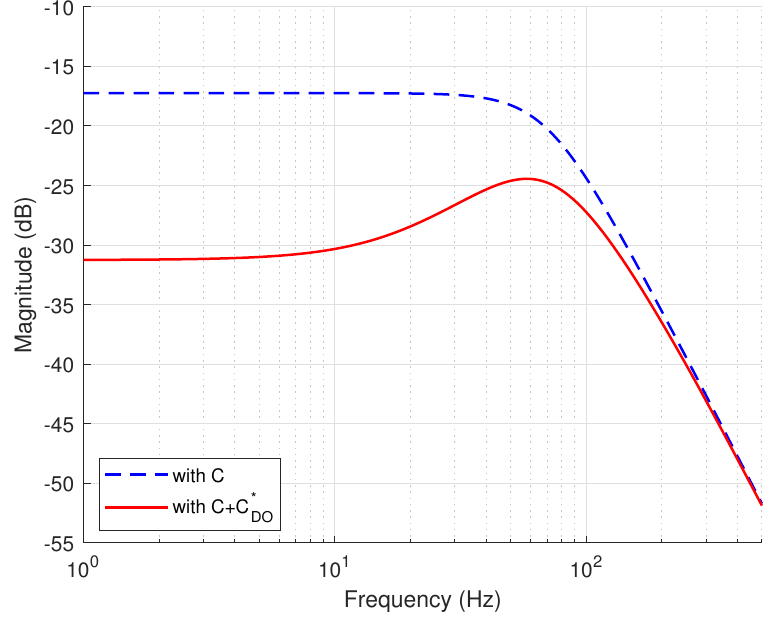
Figure 12. Designed torque transfer functions.